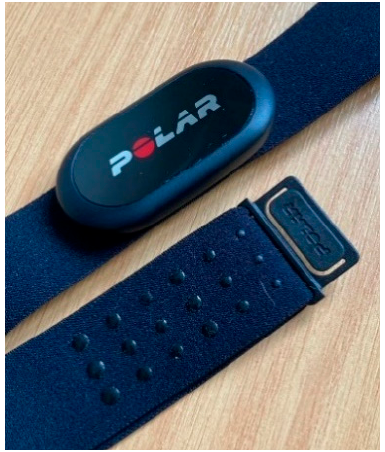
Figure 5. Polar H10 chest strap. Figure 4. Polar H10 chest